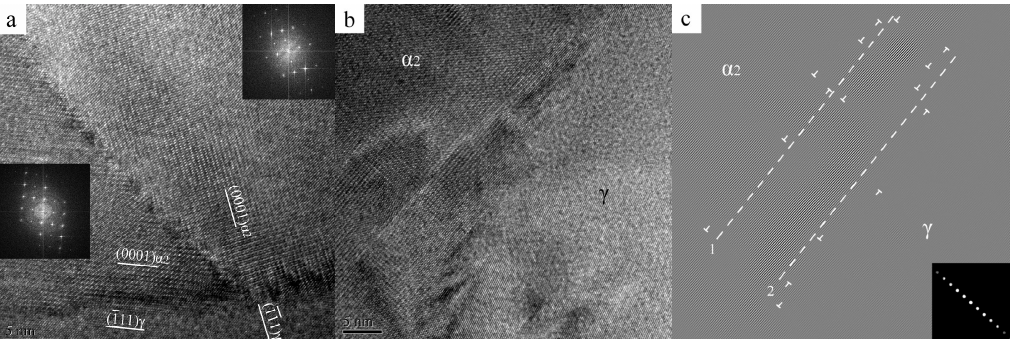
Figure 7. HRTEM images of the interfaces formed by two α 2 variants ( a ) and α 2 lath and γ matrix ( b ); ( c ) the inverse FFT image of ( b ) obtained by the series of (0001) α 2 reflection, indicating the thickening mechanism of α 2 lath by the movement of ledges at the interface.